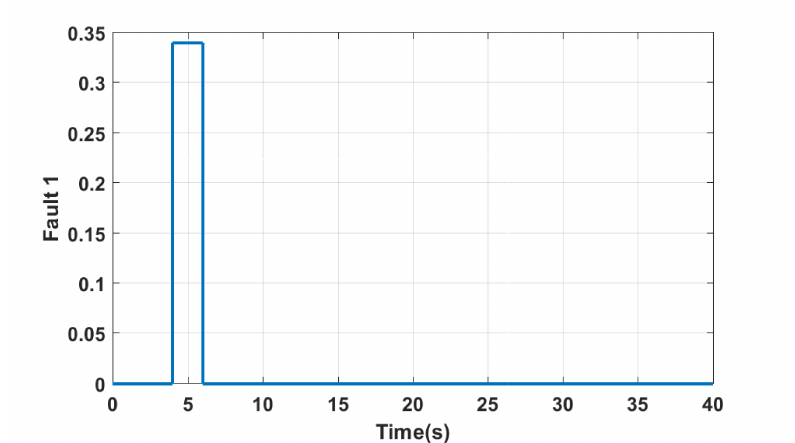
Figure 13. Fault added to the yaw sensor.